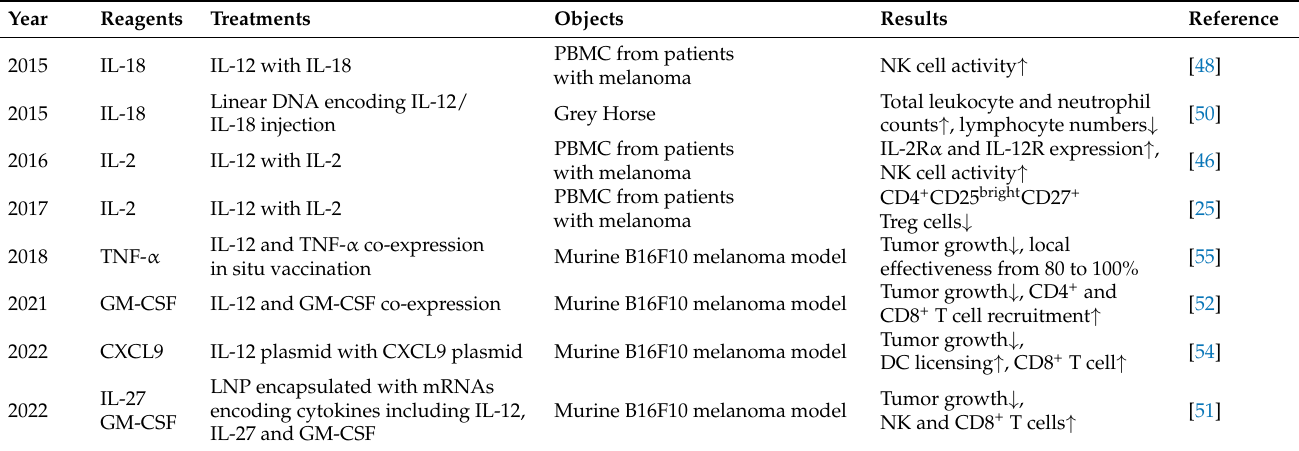
Table 3. IL-12 in combination with other cytokines for therapy of